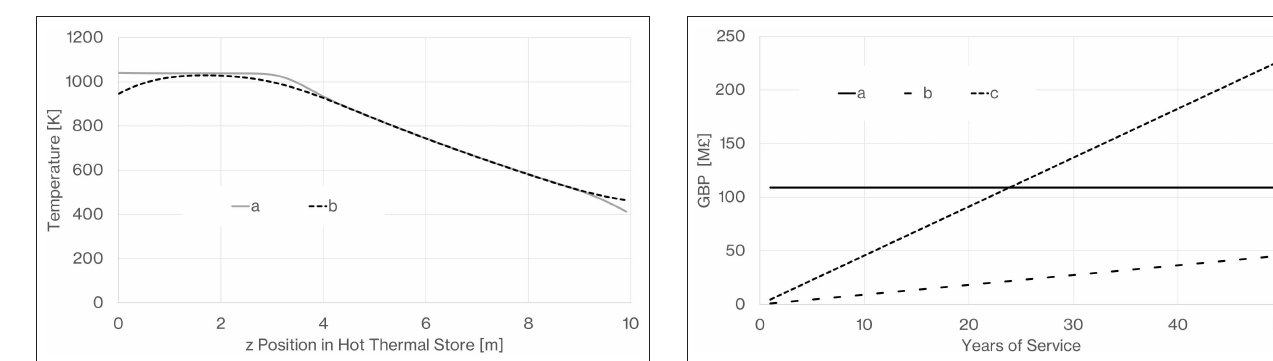
FIGURE 29 | Effect of 100h of dwell time on the hot store temperature profile ( z = 0 is top, z = 10m is bottom), a is immediately after charge phase, b is following 100h in the charged phase.